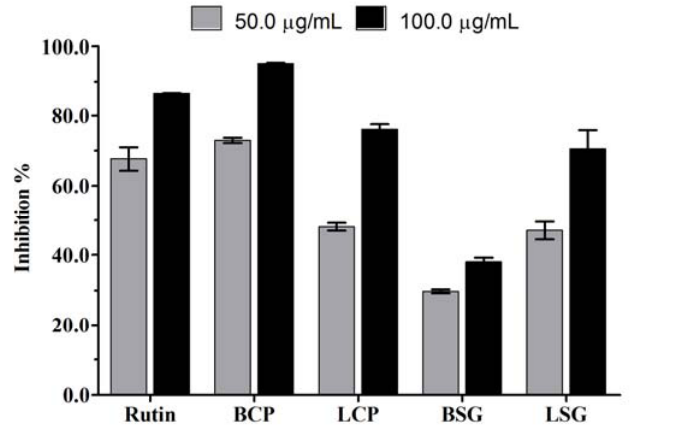
Figure 1. Radical scavenging activity of the CEE of the bark and leaves of C.pyramidalis Tul. and S. glandulosum (L.) Morong. compared with rutin. BCP = bark of C. pyramidalis ; LCP = leaves of C. pyramidalis ; BSG = bark of S. glandulosum ; LSG = leaves